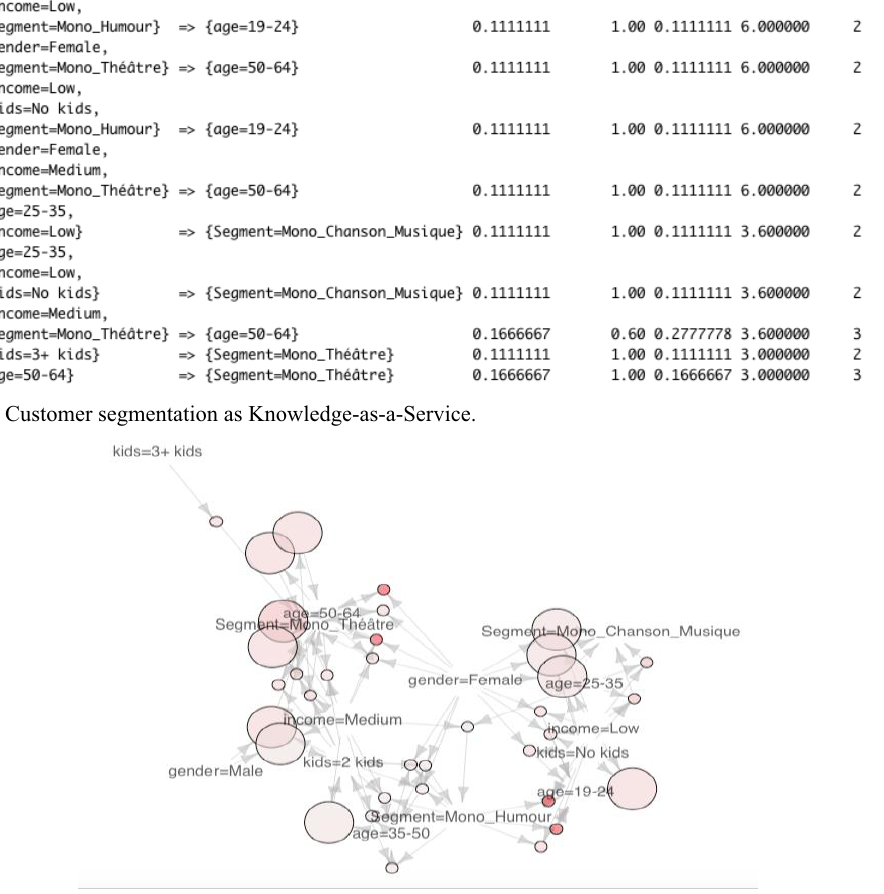
Fig. 6. Visualizing knowledge for specific